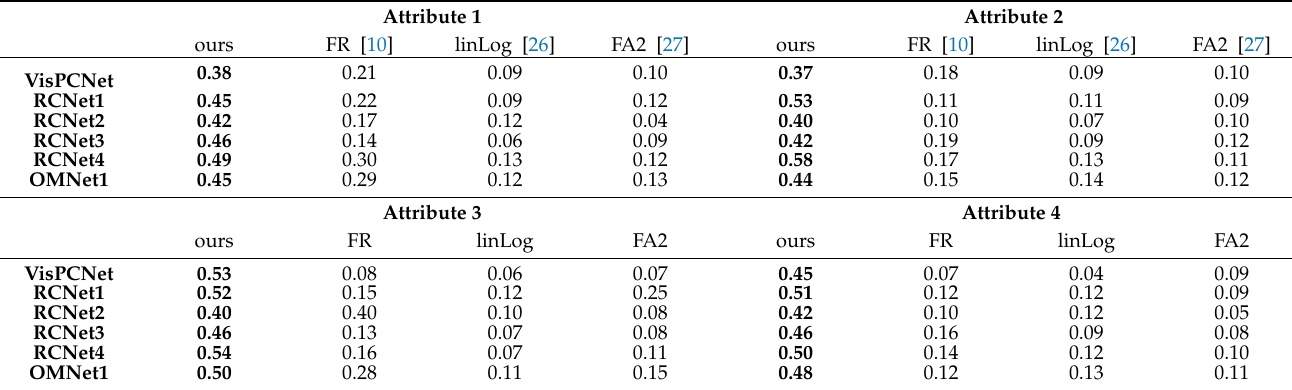
Table 3. Average distance between attribute